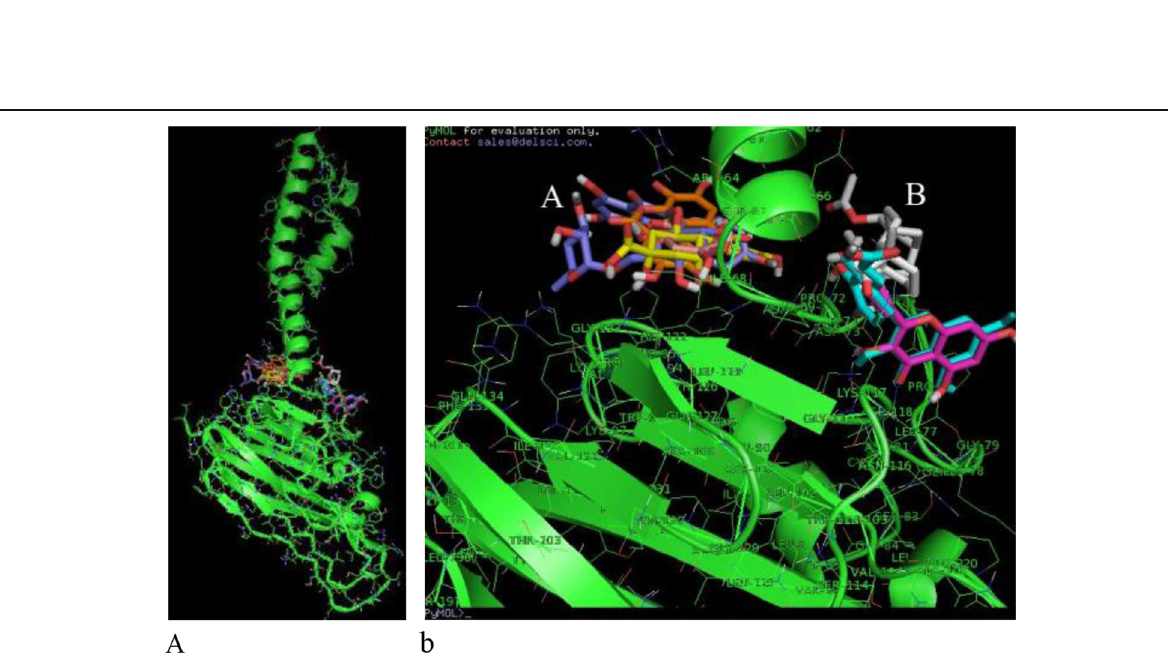
Fig. 11 Two binding pockets (A and B) for the phytochemicals a full and b close